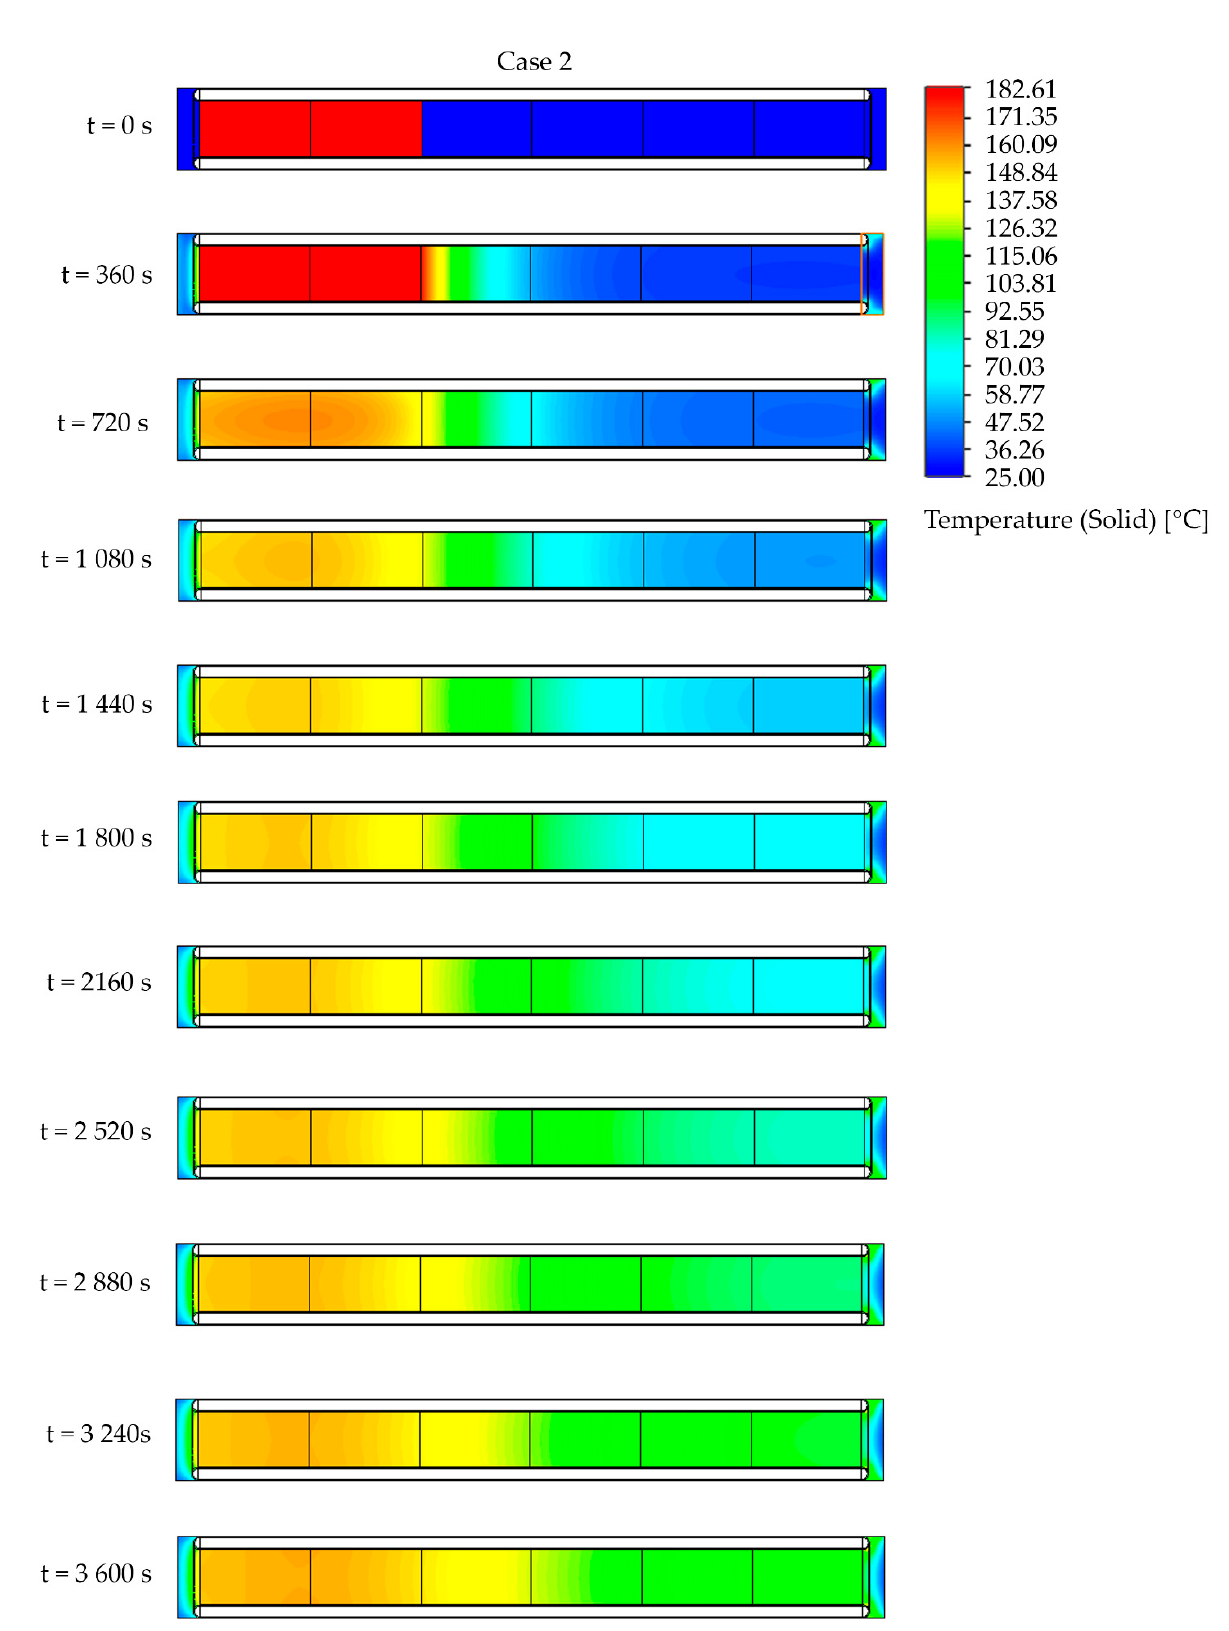
Figure 13. Temperature field in the longitudinal section view of heat accumulator in process of charging in Case 2.